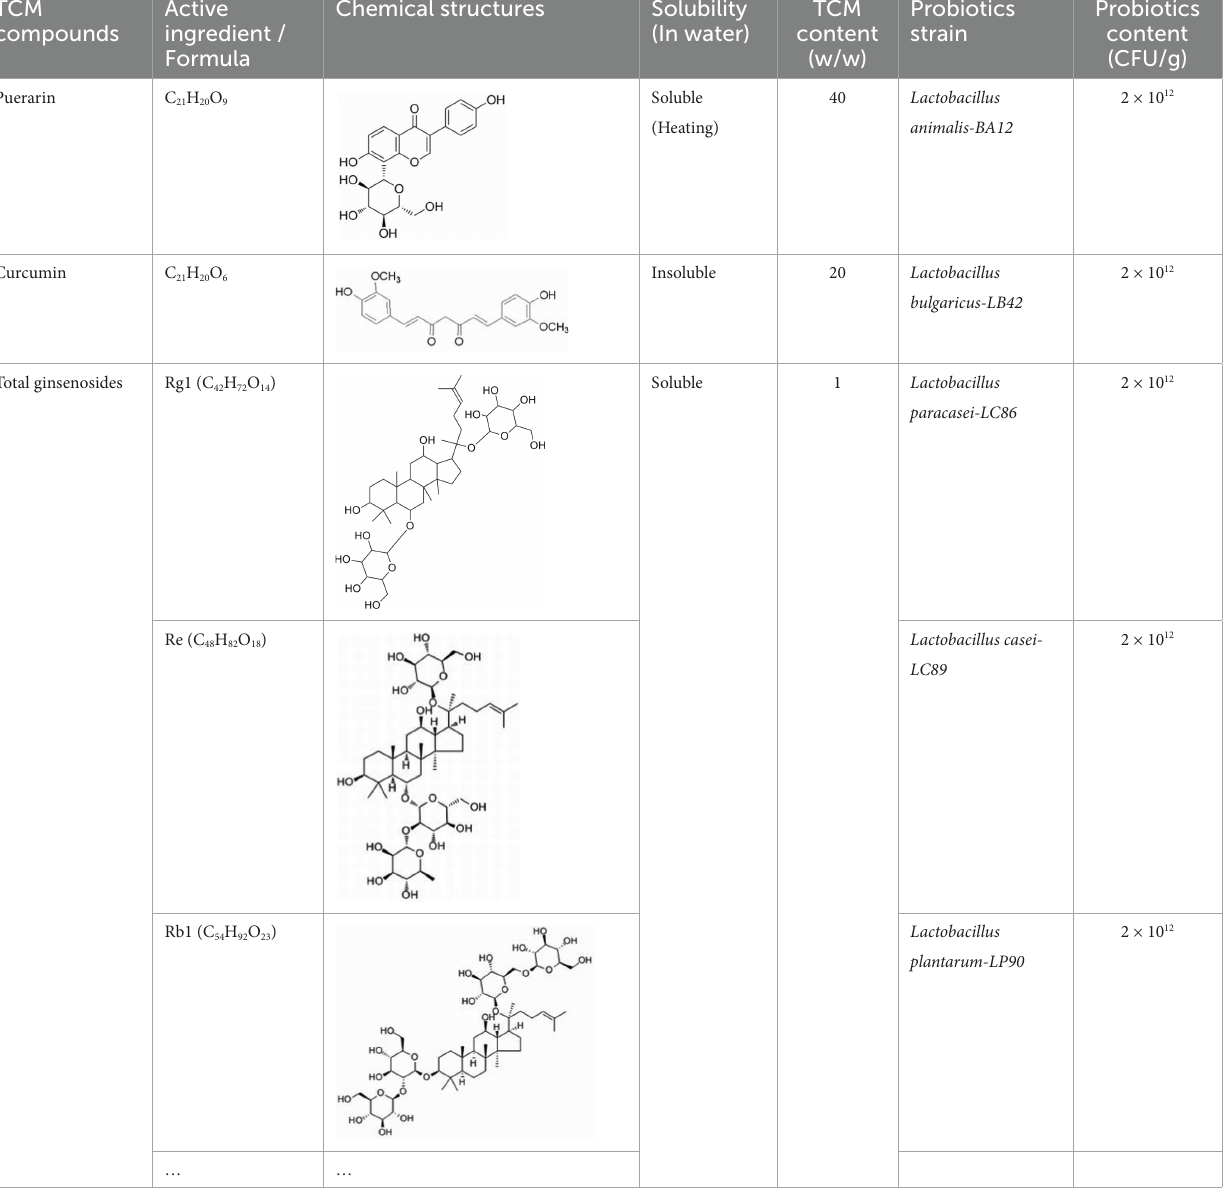
TABLE 1 The main ingredients of